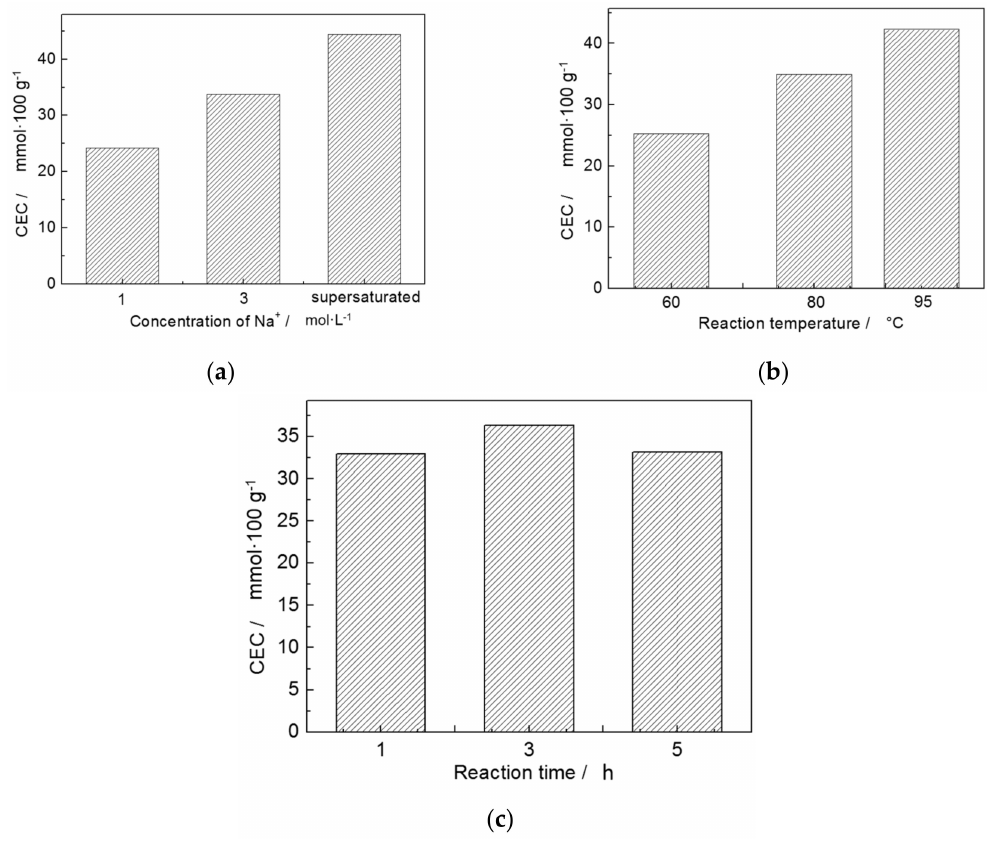
Figure 7. Effect of ( a ) concentration of Na + ; ( b ) reaction temperature; and ( c ) reaction time on CEC. Table 6. Design and results of the orthogonal experiment of sodium modification of sericite.